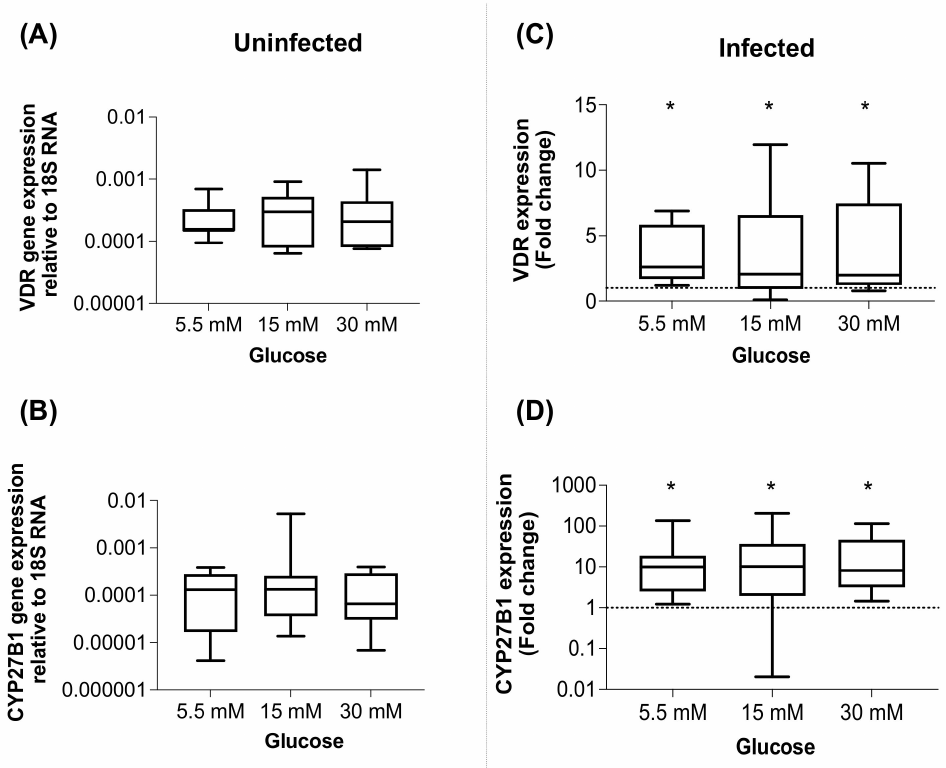
Figure 2. M. tuberculosis induces upregulation of VDR and CYP27B1. Macrophages were cultured for 24 h under different glucose concentrations (5.5, 15, or 30 mM) ( A , B ) and then infected with M. tuberculosis H37Ra at MOI 1 ( C , D ). After 24 h of additional incubation, the supernatants were removed and the macrophages lysed for total RNA extraction used for cDNA synthesis and VDR and CYP27B1 gene expression analyzed by qPCR. Uninfected macrophage gene expression is reported relative to 5.5 mM of glucose. Gene expression of the infected macrophages is reported relative to uninfected macrophages. Depicted are box plots with median and quartiles. * p < 0.01, 5.5 mM, 15 mM or 30 mM vs. Medium, Wilcoxon